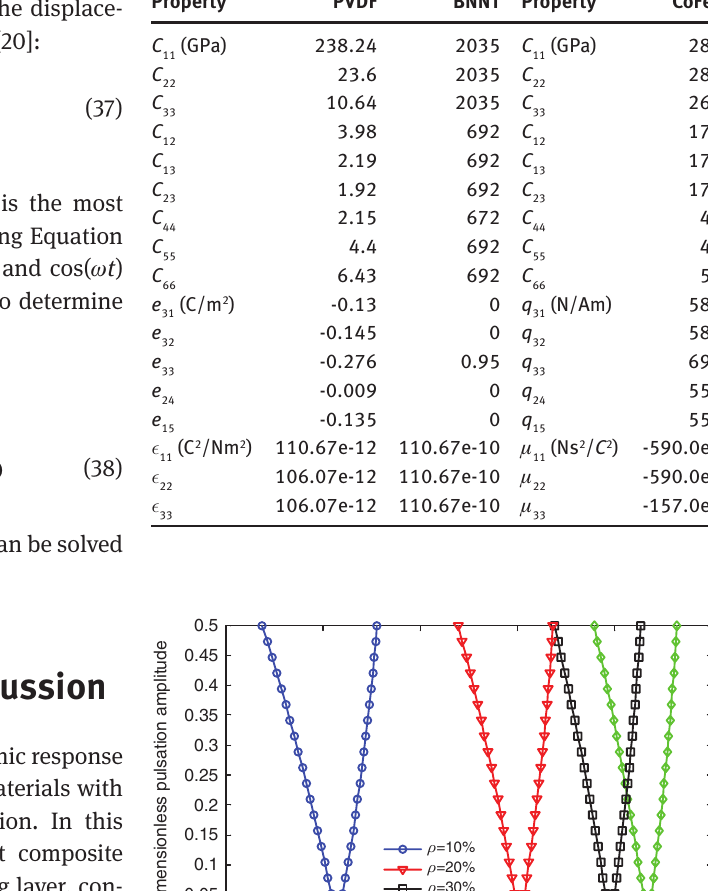
Table 1: Electro-magneto-mechanical properties of materials. Property